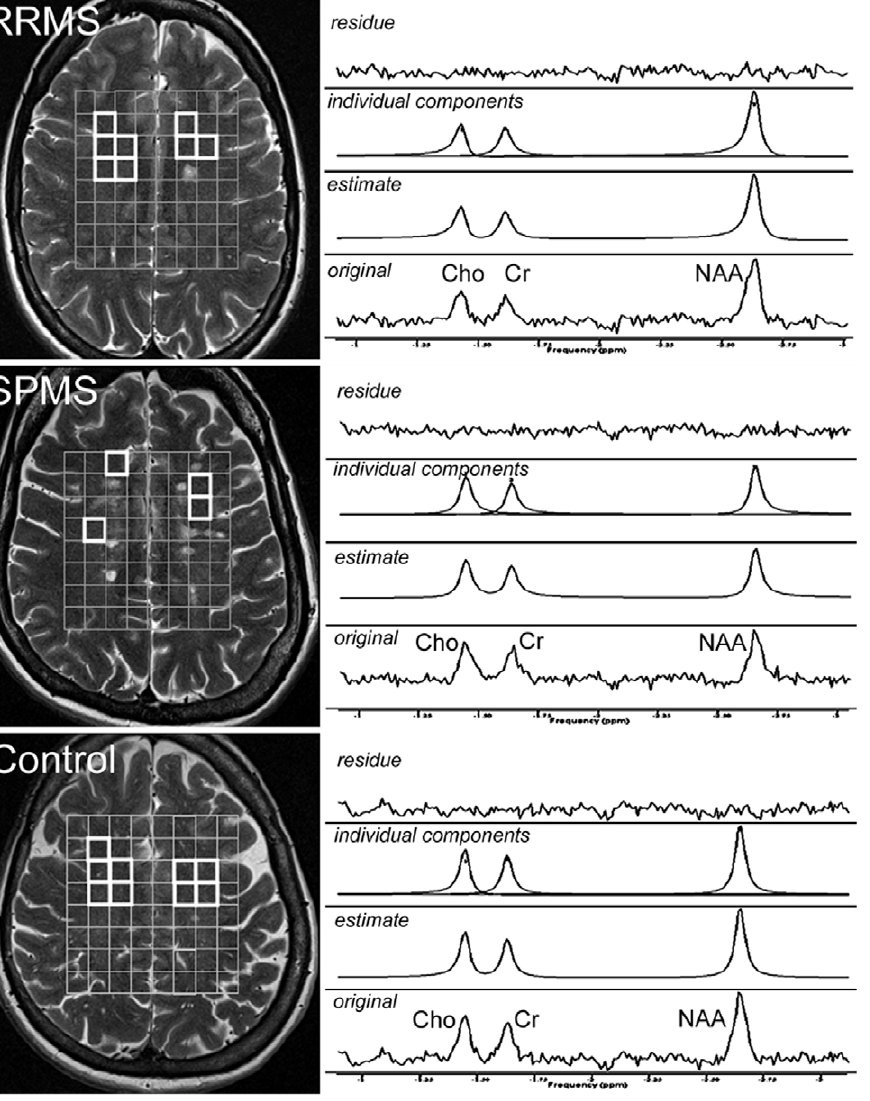
Figure 1. Spectral region including resonance lines of choline (Cho), creatine (Cr) and N-acetyl-aspartate (NAA). Left column , anatomical T2w MR Images with the depiction of MRSI PRESS box volume of interest (grey, 8 6 8 cm) and voxels (white) in the NAWM chosen for the spectroscopic data evaluation. Right column , representative MR spectra from a single voxel with original spectra (lower trace), AMARES estimate (second trace), individual components (third trace) and fit residue (upper trace). Data from RRMS (upper part) and SSPMS (middle part) patients as well as healthy controls (CON, lower part) are presented.